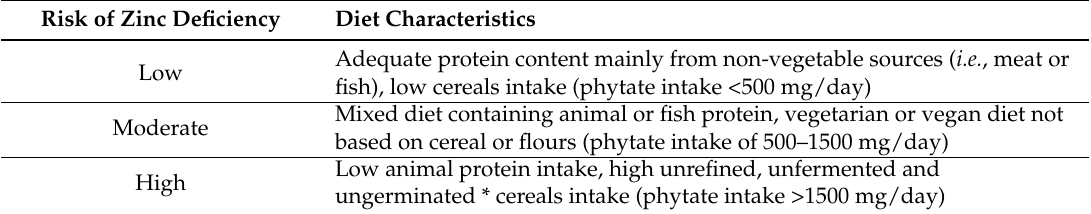
Table 3. Risk magnitude of zinc deficiency during pregnancy according to maternal diet [45–47].